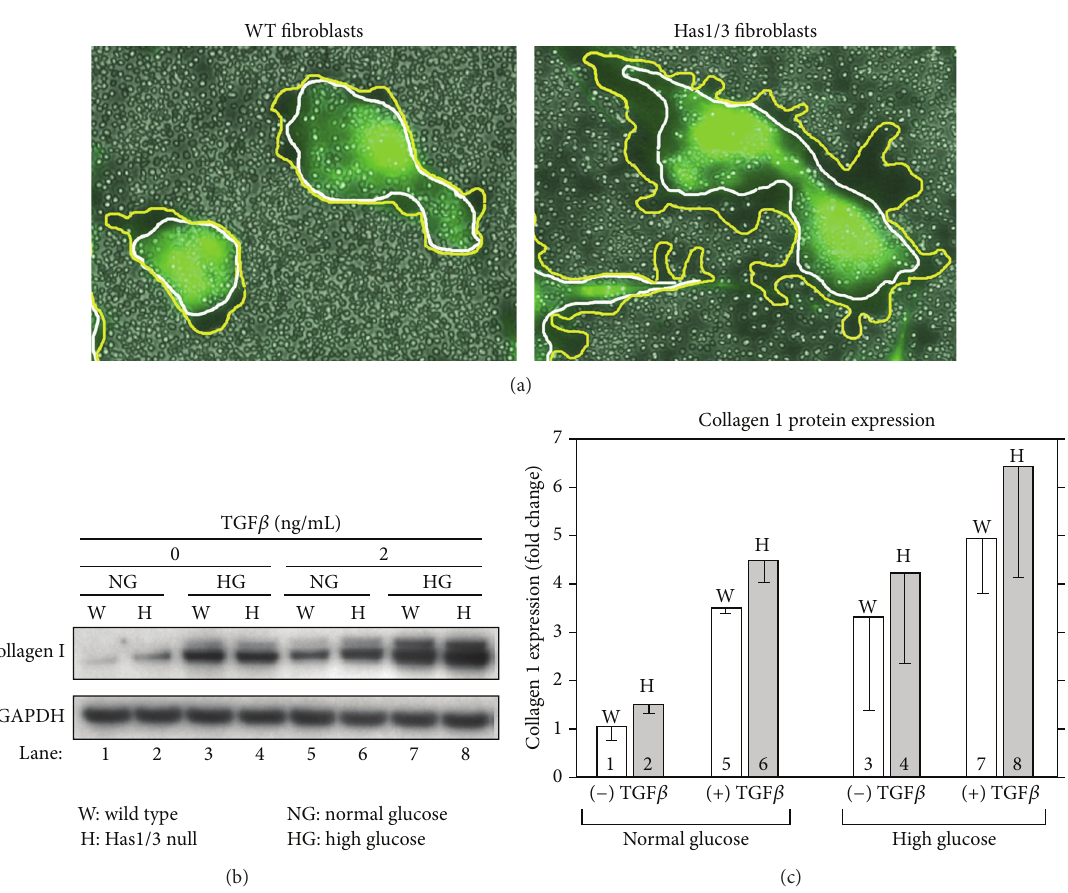
Figure 2: Skin fibroblasts with a larger HA glycocalyx are more responsive to TGF- 𝛽 and produce more collagen when cultured in a high glucose medium. Skin fibroblasts from either wild type (WT) or Has1/3 null mice were cultured in normal glucose (1g/L) or in high glucose (4.5 g/L) in the absence or presence of TGF- 𝛽 1 (2ng/mL) in DMEM media with 1% FBS for 48 hours. (a) Erythrocyte exclusion assay to visualize the pericellular coat on WT and Has1/3 null fibroblasts [51]. Cells were labeled with calcein to delineate the cell bodies. The HA glycocalyx is indicated between the white and yellow lines. (b) Western blot of protein from WT or Has1/3 null fibroblasts, probed with an antibody to type 1 collagen. GAPDH, loading control. (c) Quantification of protein band intensities from two independent western analysis experiments, performed under the conditions shown in panel (b) and normalized to GAPDH. White bars , WT fibroblasts. Gray bars , Has1/3 null fibroblasts. Error bars , mean ±